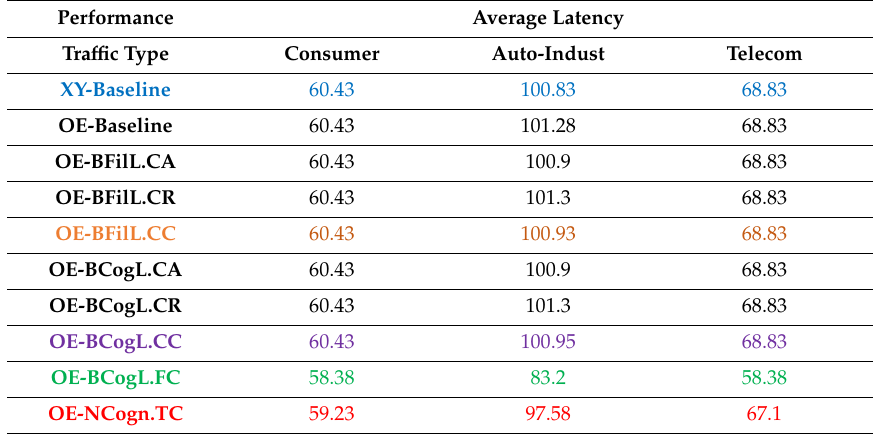
Figure 16. Task mapping results (top) and performance variations in latency (middle) and throughput (bottom) under ( a ) consumer, ( b ) auto-indust, and ( c ) telecom traffics. Table 5. Performance comparisons in average latency among different traffic control schemes and real traffic types.